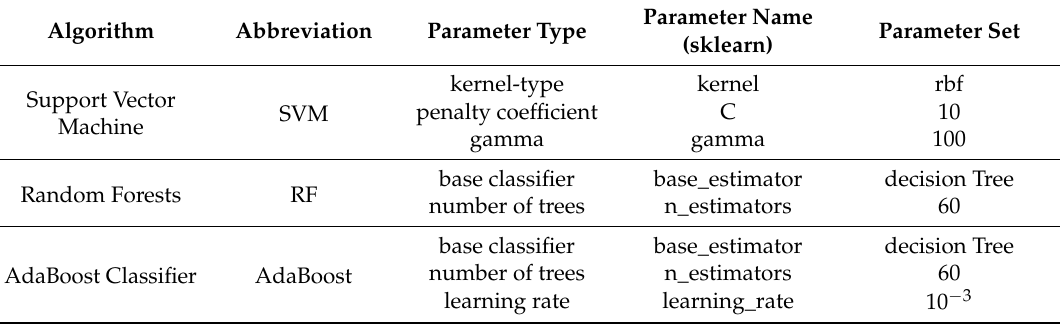
Table 3. Parameters of the classifiers used in our experiments (Python sklearn).